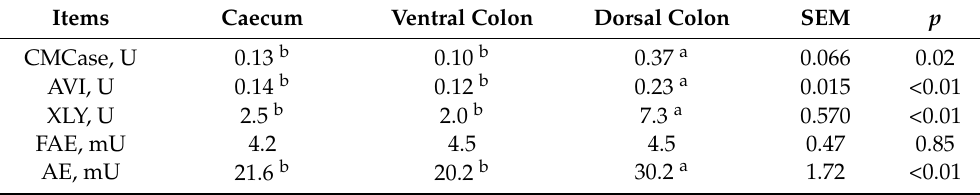
Table 2. The fibrolytic enzyme profiles in cecum, ventral colon, and dorsal colon of Dezhou donkeys.